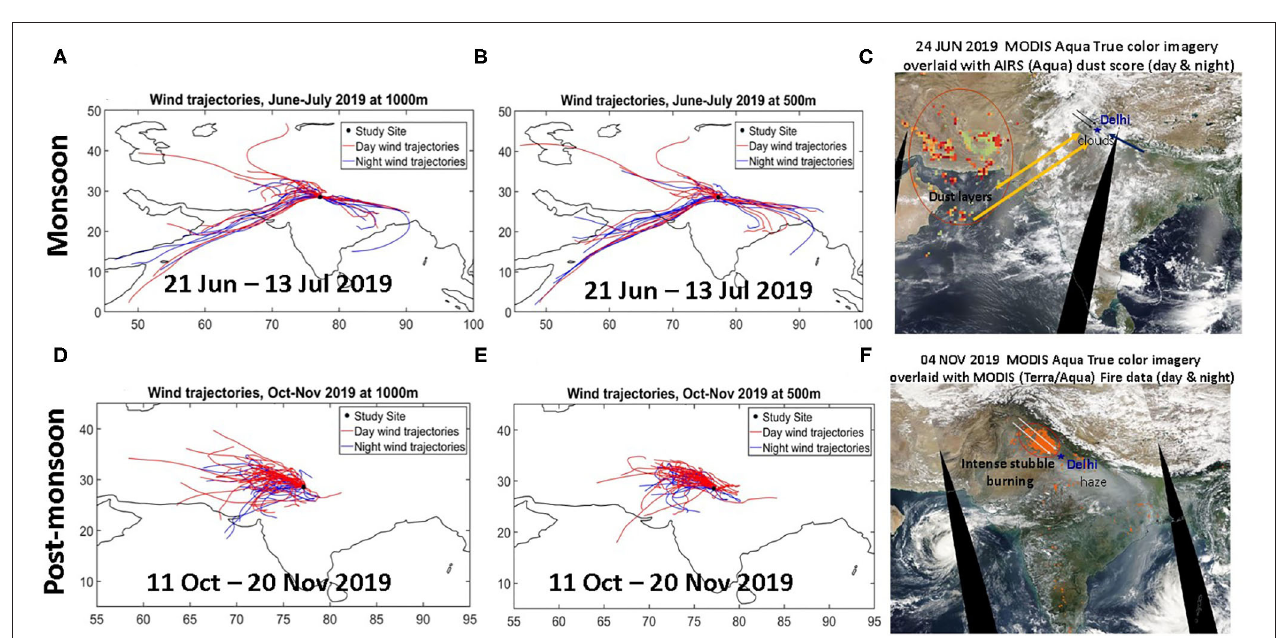
FIGURE 4 | HYSPLIT derived air-mass back trajectories during (A,B) monsoon (21 Jun − 13 Jul 2019) season and, (D,E) post-monsoon (11 Oct − 20 Nov 2019) season at 1,000m and 500m. Day time and night time wind trajectories are shown by red and blue colors, respectively. (C) MODIS aqua true color imagery overlaid with AIRS dust scores for 24 Jun, 2019 (major wind direction at receptor site are shown by arrows). (F) MODIS aqua true color imagery overlaid with MODIS fire counts for 4 Nov, 2019 (major wind direction at receptor site are shown by arrows).